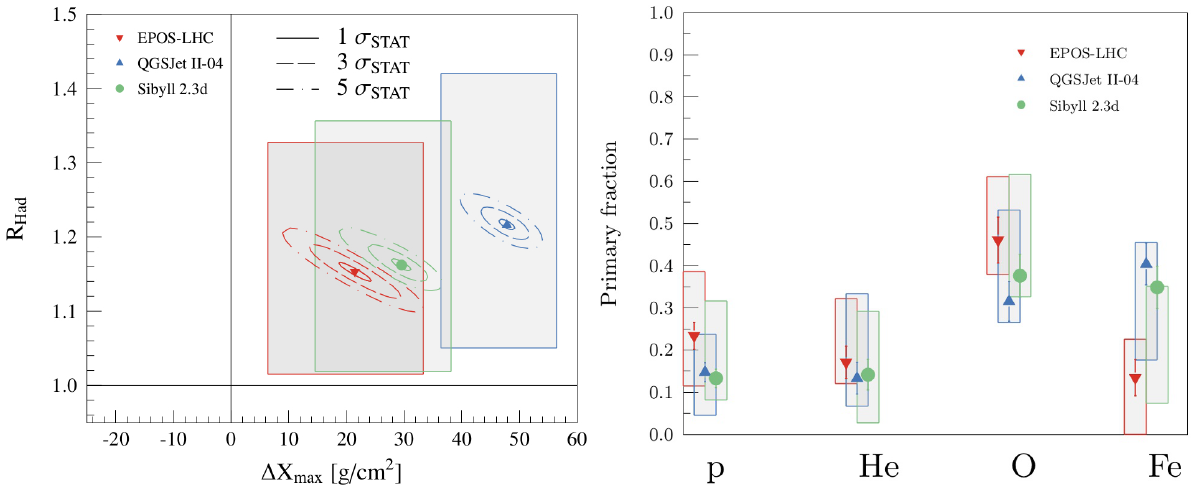
Figure 7: Best-fit values of the fitted parameters R Had and ∆ X max (left) and primary fractions (right) for all three models of hadronic interactions. The systematic uncertainties are depicted by gray